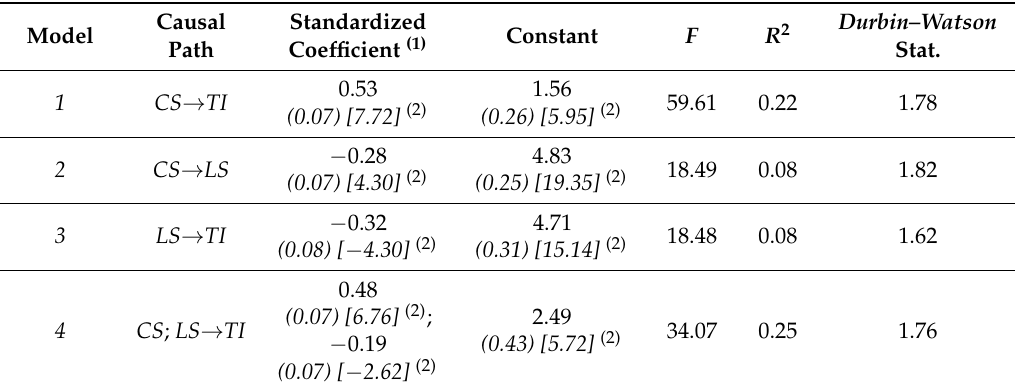
Table 12. Estimated causal relationships between CS, LS, and TI ( N:214 ). (CS: Commuting stress, LS: Life satisfaction, TI: Turnover intention).